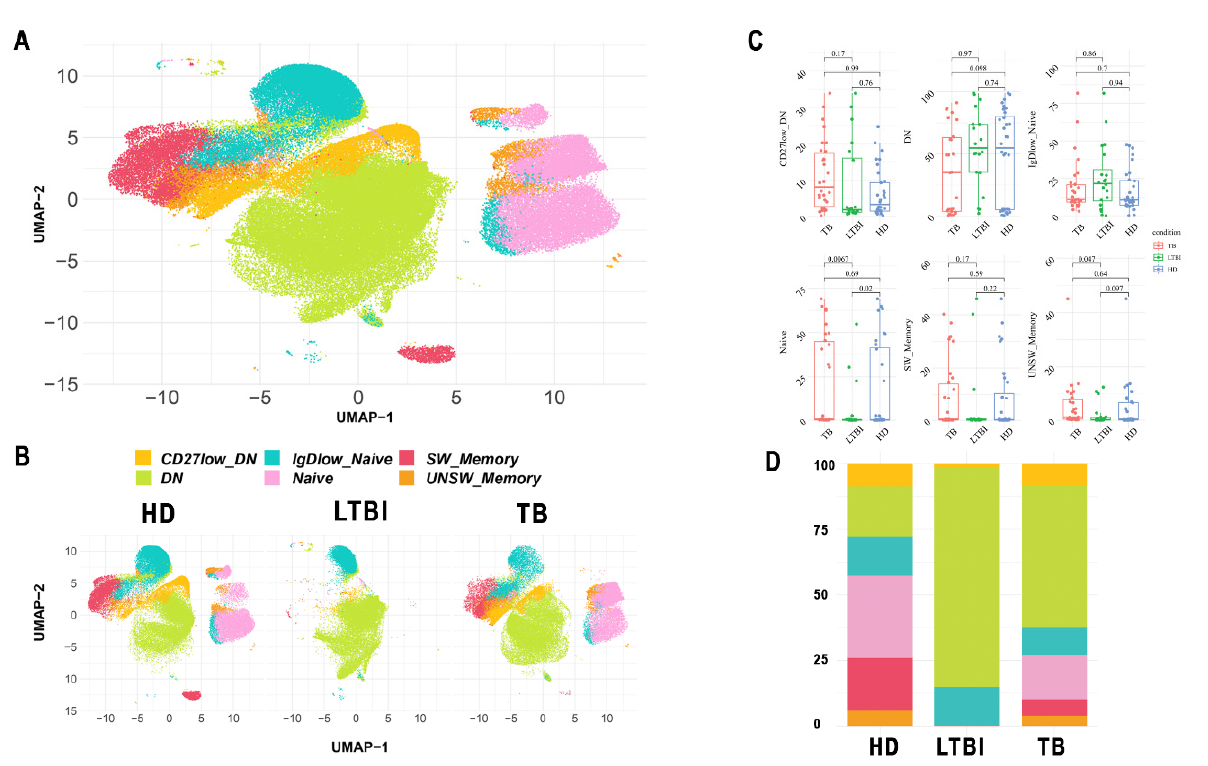
Figure 3. Clustering and cell subset identification: ( A ) After normalization and dimensional reduction, all B cells were clustered into six sub-clusters. An initial clustering step to sort all B cells was used. ( B ) The final clustering of different subsets clearly showed that no batch effect related to condition could be identified based on cell markers; the initial cell subset clustering using FlowSOM was performed on all cells. ( C ) B cell clusters identified by FlowCT evaluated according to condition; the two-tailed Anova test was used for sub-cluster changes in different conditions; p -value < 0.05 is considered a statistically significant change. ( D ) Proportion of each sub-cluster in different conditions.